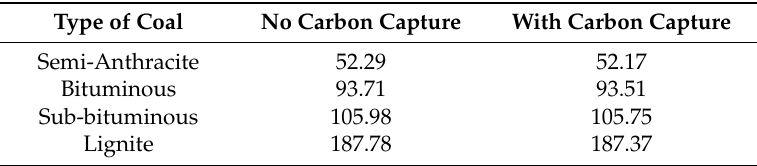
Table 11. Lifetime coal requirement (Unit: